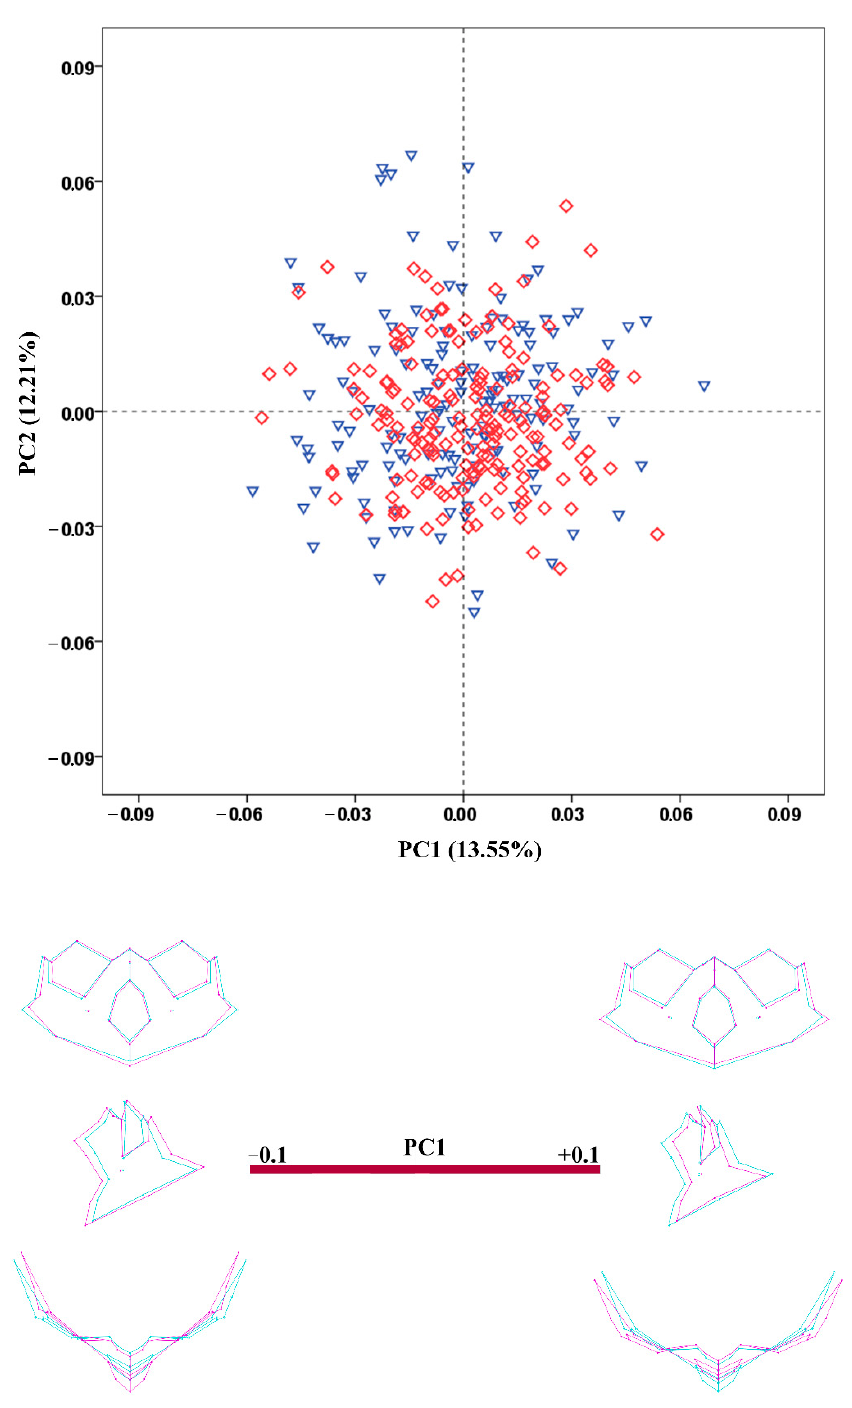
Figure 3. PCA scatterplot for the viscerocranium configuration. The wireframes illustrate the shape variation along the axis of PC1. Male crania—blue triangles; female crania—red rhombs; extreme shape configurations—purple wireframes; mean shape configuration—light blue wireframe.